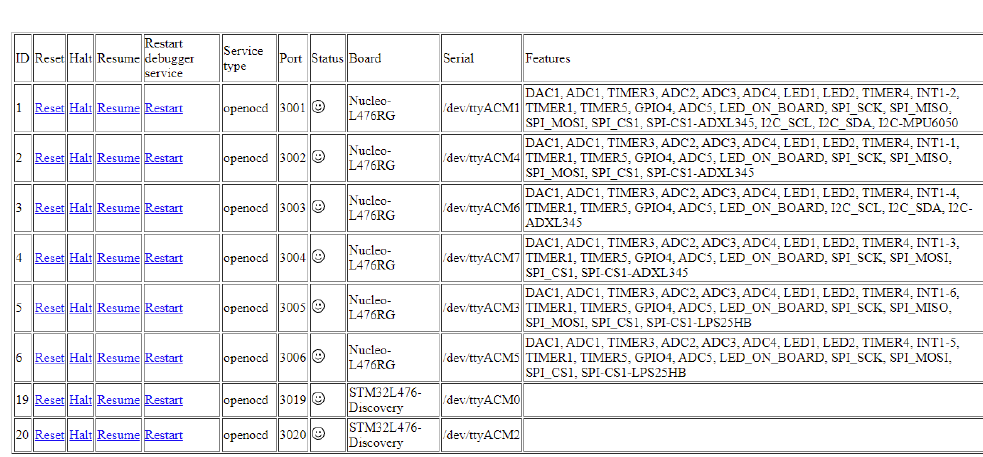
Figure 7. Status server view for Aries